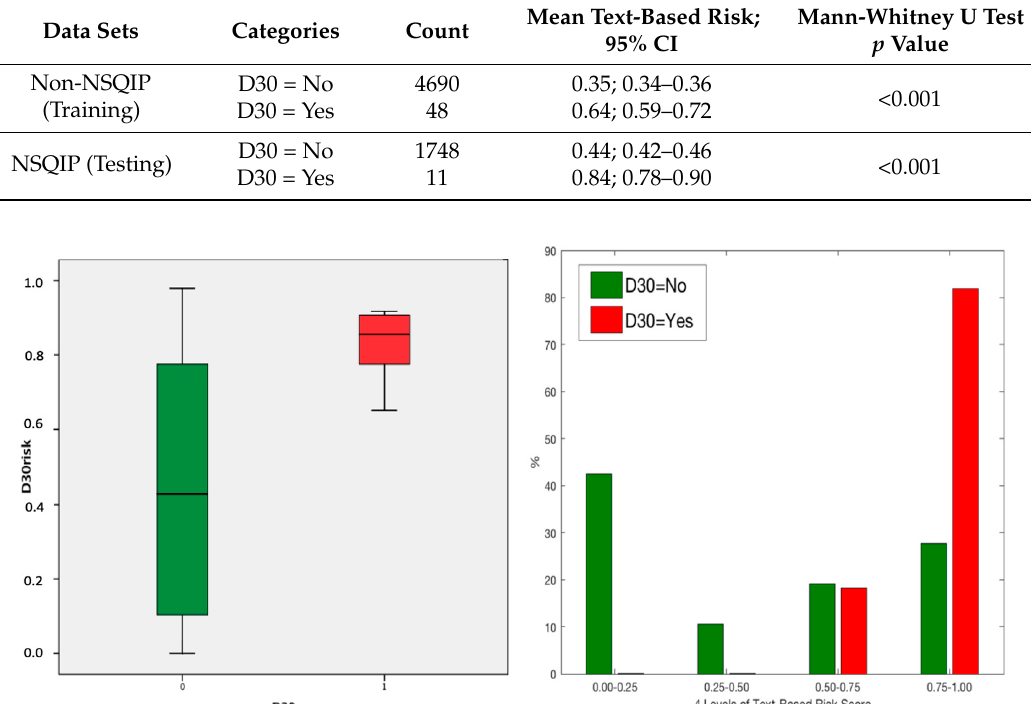
Figure 3. ( Left ) Text-based risk scores for training cohort for D30: 0 (No, Green) and 1 (Yes, Red). ( Right ) Observed D30 (percentage) for four different levels of text-based risk scores.